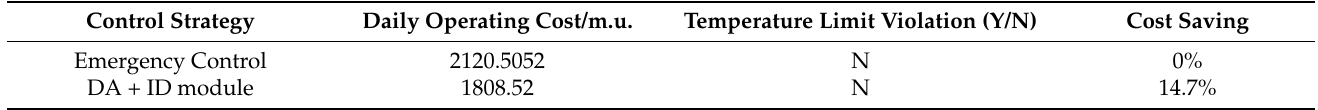
Table 4. Port operating cost